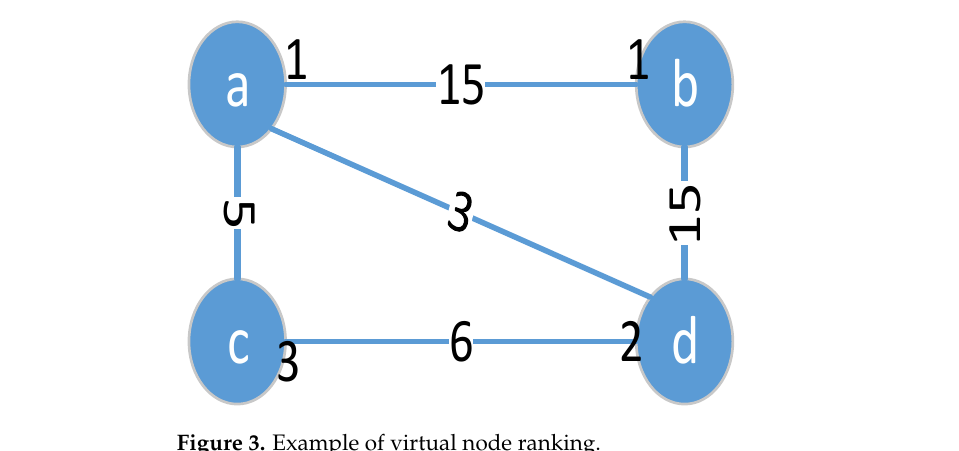
Figure 3. Example of virtual node ranking.